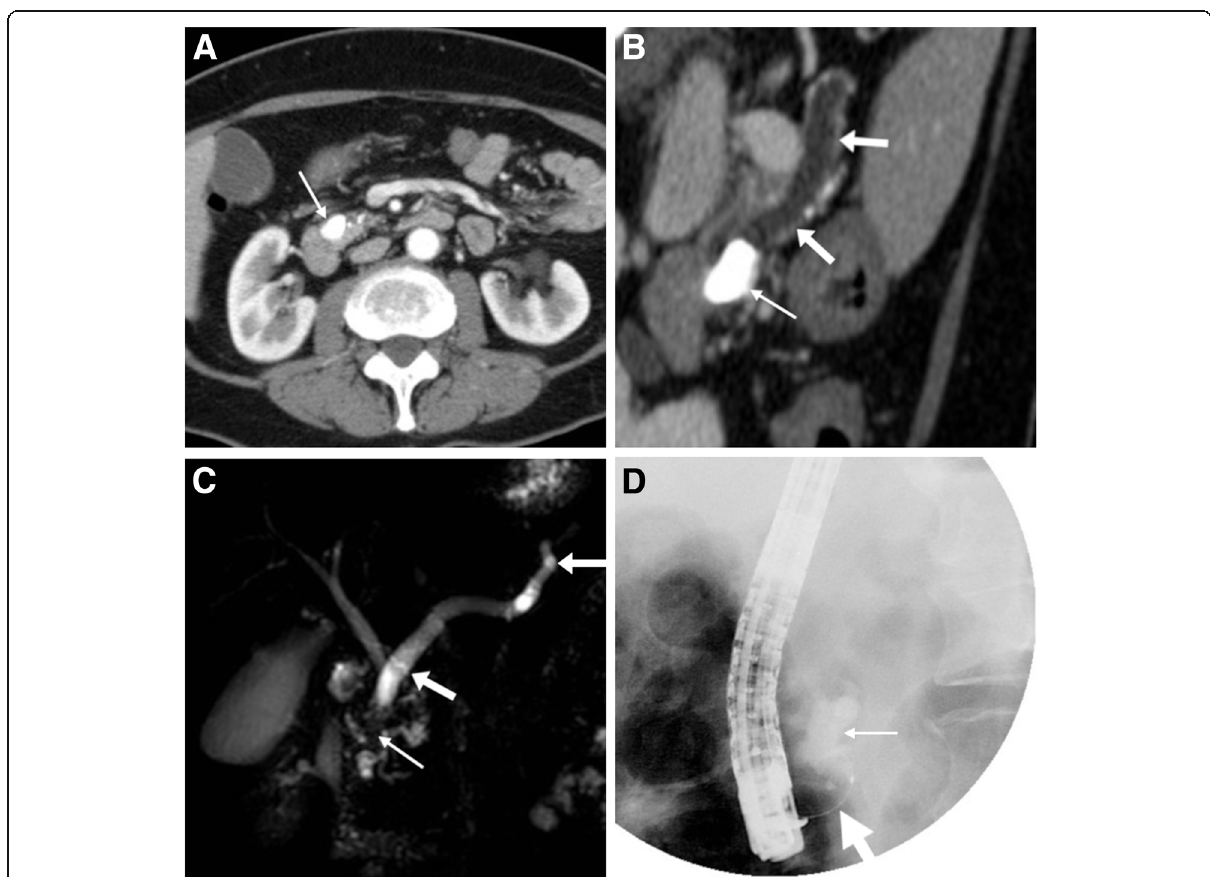
Fig. 5 In a 63-year-old female with idiopathic chronic pancreatitis (CP) and parenchymal thinning long neck, body and tail of the pancreas, contrast-enhanced MDCT (axial image a , oblique reformation along MPD in b ) showed diffusely dilated (maximum caliber 9 mm) MPD (arrows) upstream to a distal, densely calcified stone (thin arrows) measuring approximately 1.5 cm. MRCP ( c ) confirmed large intraductal stone as signal void (thin arrow) at distal MPD causing upstream obstruction. Endoscopic fragmentation ( d ) was unsuccessful due to impeded passage of guidewire, so the patient underwent extracorporeal shock wave lithotripsy (adapted from Open Access ref. no.